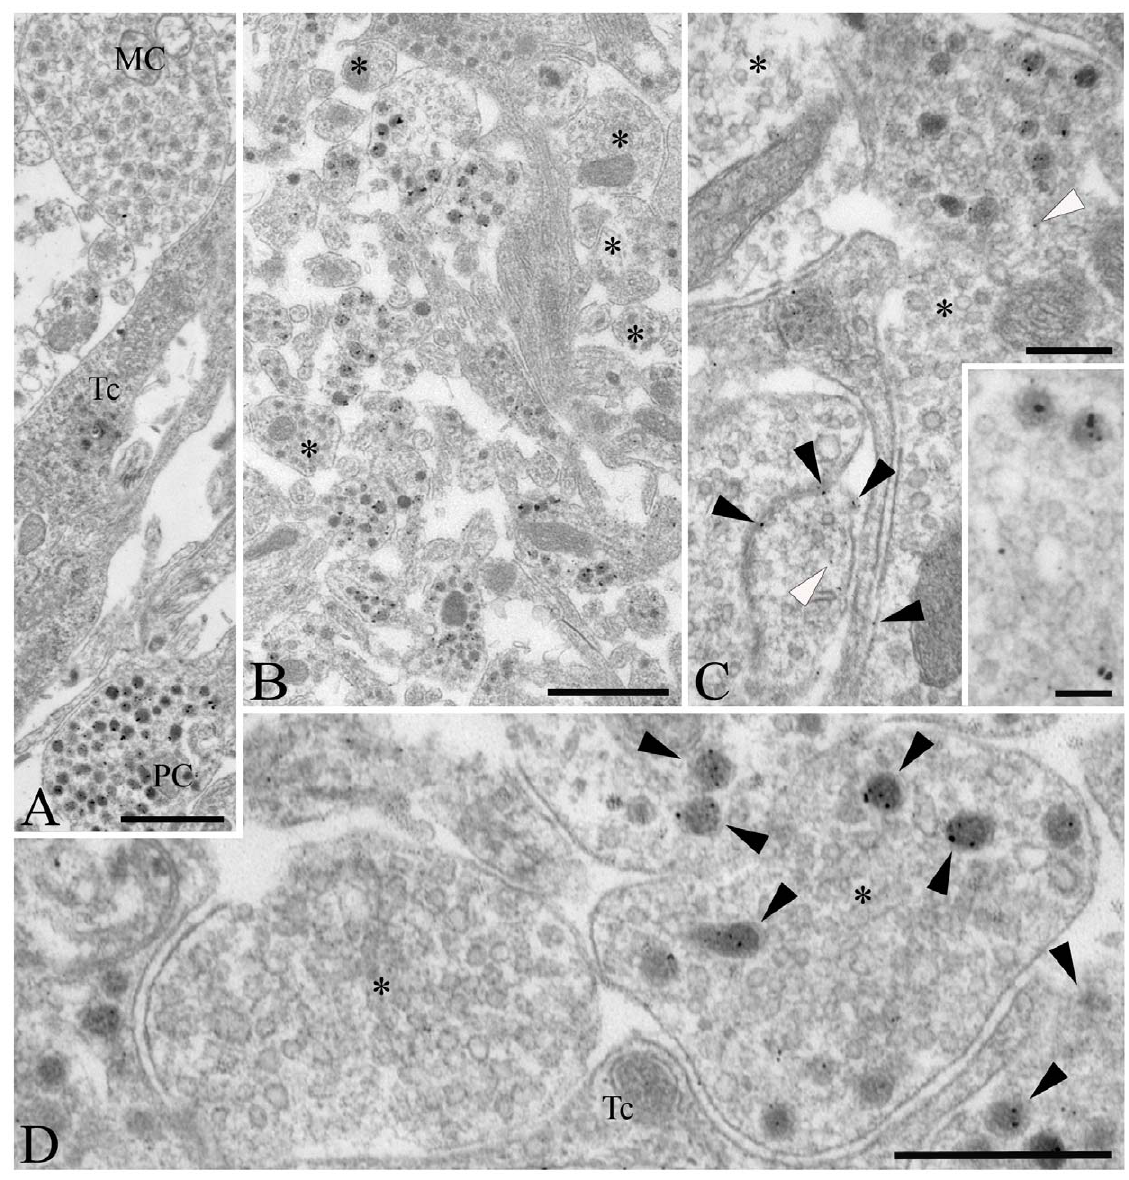
Figure 2. Ultrastructure of D3 immunoreactive elements in the rat mediobasal hypothalamus. ( A ) D3 immunoreactivity, identified by silver grain deposits, appear primarily in axon varicosities containing dense core vesicles of 80–120 nm diameter in the upper external zone of the median eminence, characteristic of axons of parvocellular (PC) neurons. No or a few silver grains could be observed in association with organelles of magnocellular neurons (MC) or tanycytes (Tc), respectively. ( B ) D3-positive axons exhibiting various degrees of labeling are mixed with non-labeled fibers (asterisks) in the external zone of the median eminence. ( C ) Although silver grains occasionally appear in association with the plasma membrane (black arrowheads) and with small clear vesicles (white arrowheads) of the axon varicosities, the majority are not labeled (asterisks). ( D ) In contrast, the dense core vesicles accumulate most the reaction product (black arrowheads), as visible at high power magnification in the vicinity of the capillaries of the external zone of the median eminence. Unlabeled small clear vesicles are indicated with asterisk. Tc, tanycyte; Scale bars: 1 m m in A–B, 250 nm in C, 100 nm in inset on C, 500 nm in D.